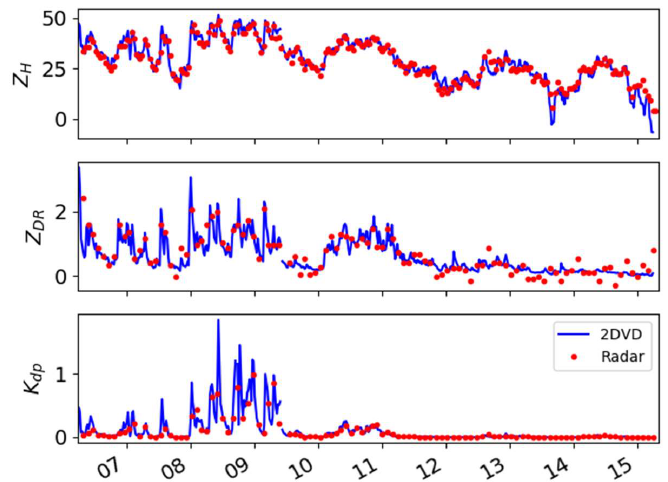
Figure 13. Time-series data of the polarimetric variables: ( a ) Z h (dBZ); ( b ) Z dr (dB); and ( c ) K dp (deg km −1 ). The data were collected between 0614 and 1519 UTC on 8 June 2014. The blue curve indicates disdrometer observations, and the red dots are the radar measurements.